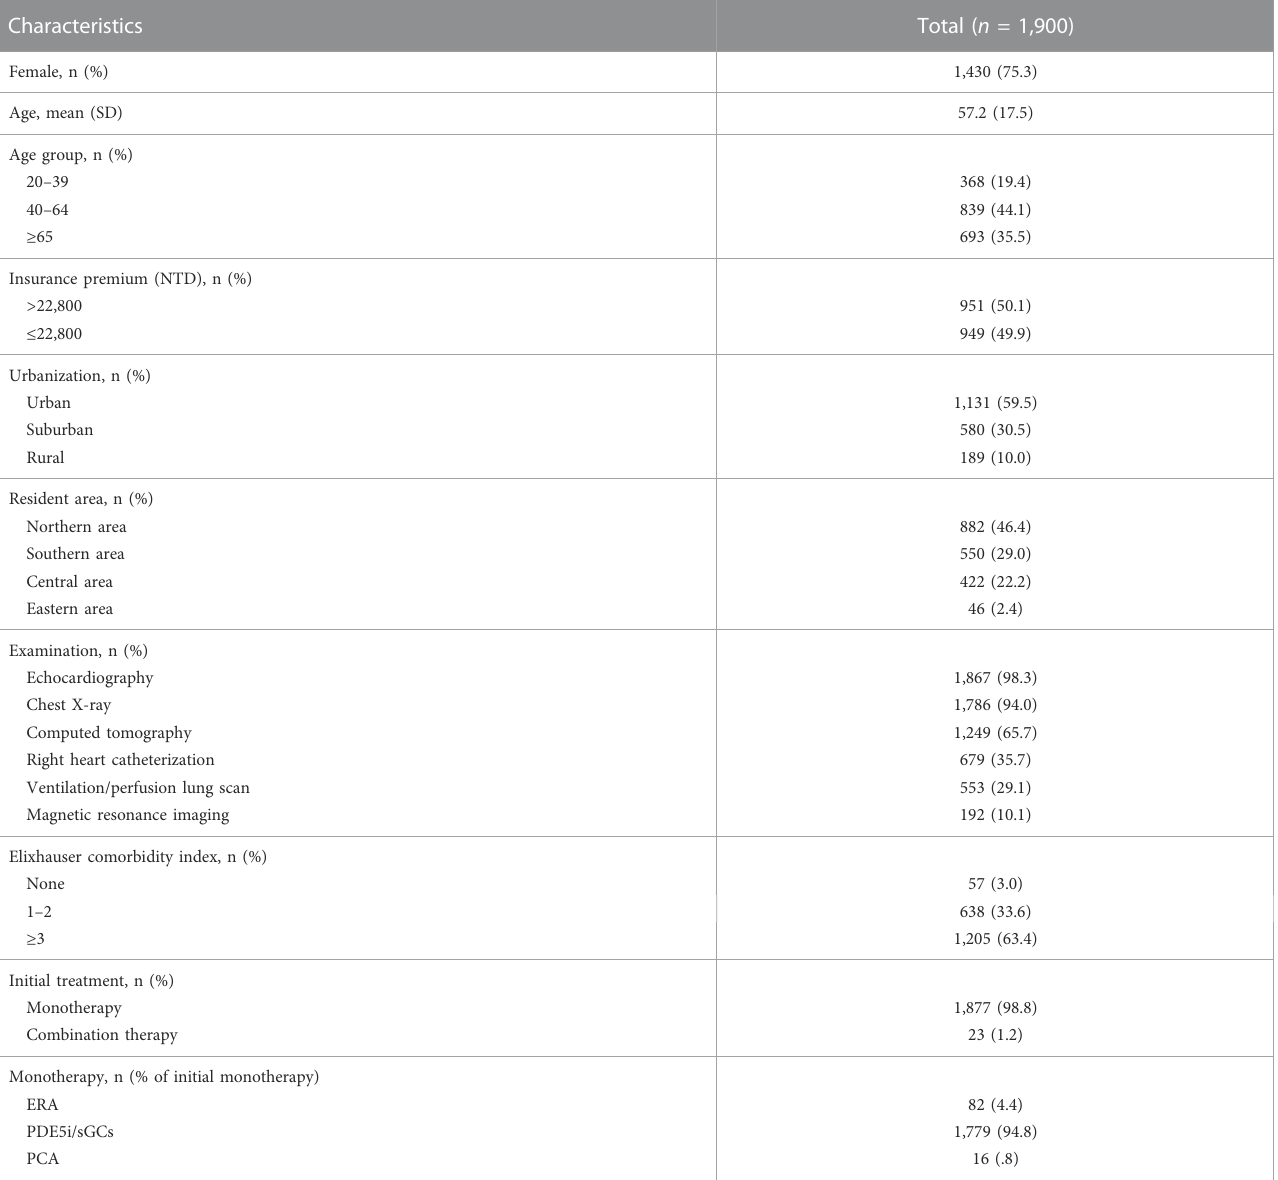
TABLE 1 Baseline characteristics and initial